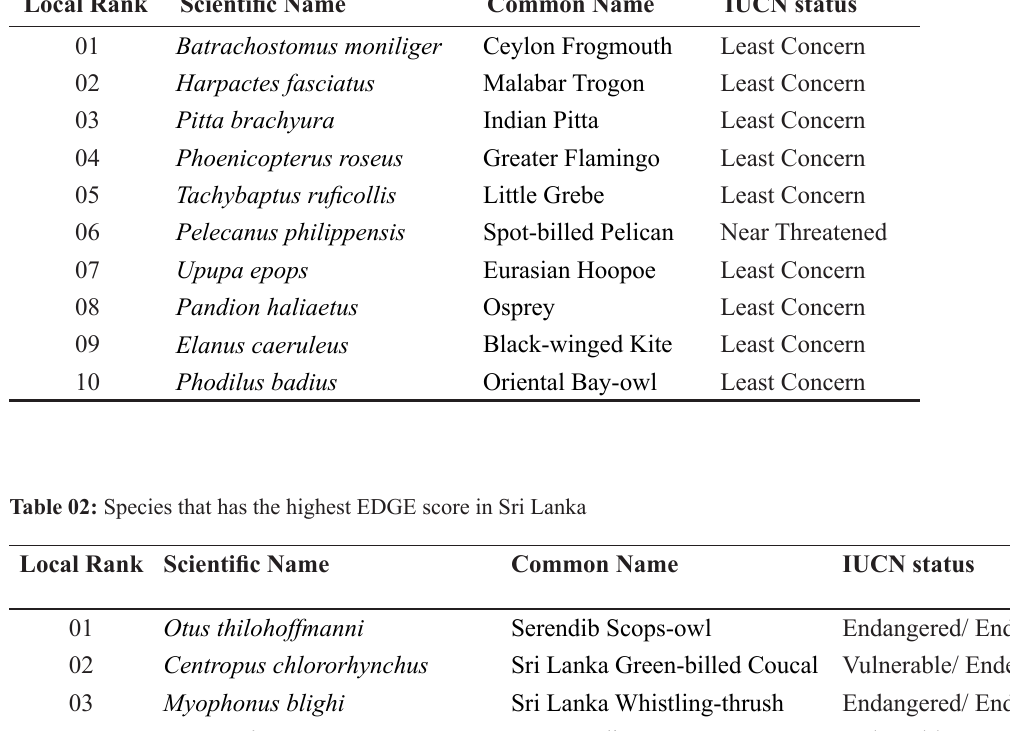
Table 01: Species that has the highest evolutionary distinctness (ED) in Sri Lanka Local Rank